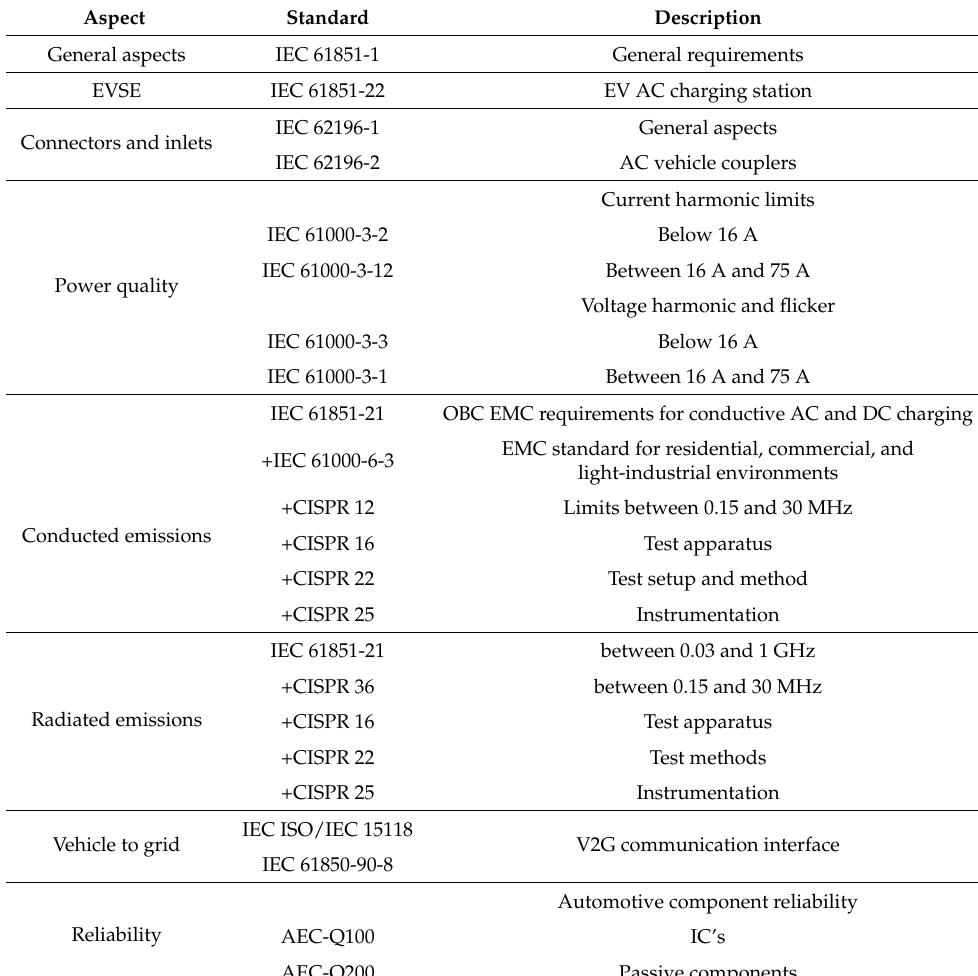
Table 3. International standards related to the OBC